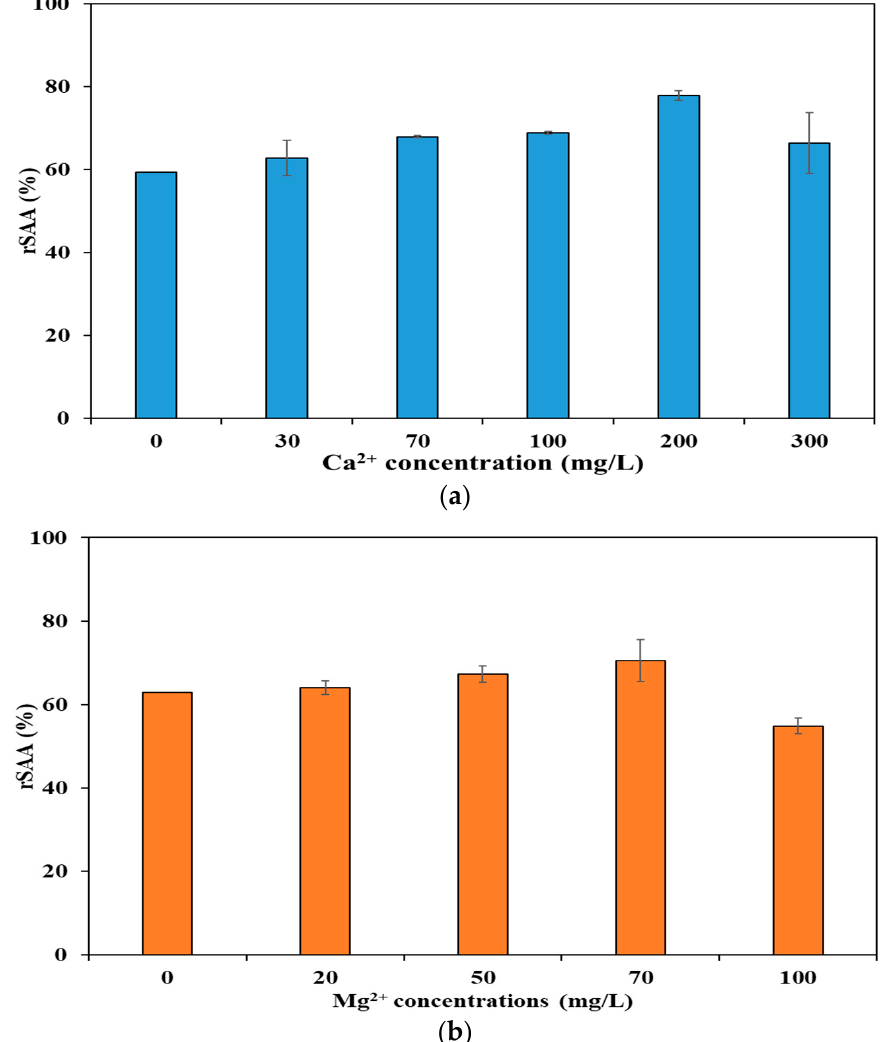
Figure 2. Effect of the Ca 2+ ( a ) and Mg 2+ ( b ) concentrations on relative specific anammox activity (rSAA, %) at 5 g/L of salt concentration.